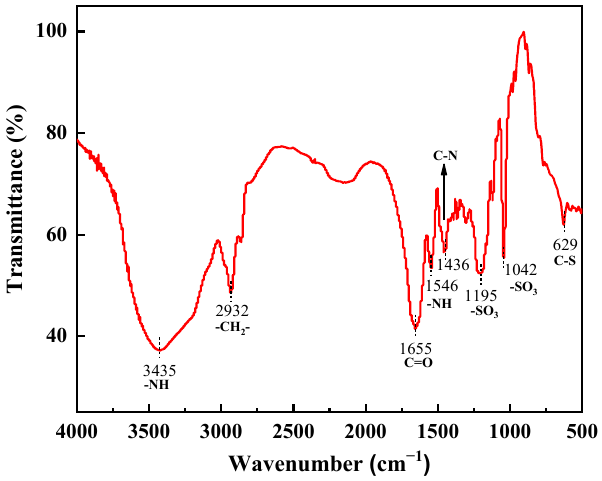
Figure 1. FTIR spectrum of AADN.